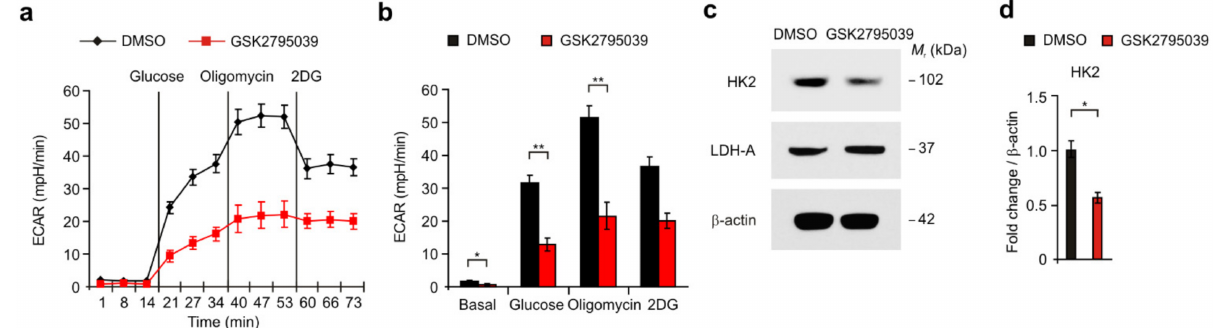
Figure 3. Inhibition of NOX2 suppresses the activation of HK2-dependent glycolysis in human glioma cells. ( a ) The levels of extracellular acidification rate (ECAR) for glycolysis of glucose and ( b ) quantifi- cation of ECAR levels in human glioma cells treated with GSK2795039 or DMSO. ( c ) Representative immunoblot images and ( d ) quantification of NOX2, HK2, and LDH-A protein levels in human glioma cells treated with GSK2795039 or DMSO. β -actin was used as a loading control. The results are representative of three independent experiments and are shown as the mean ± SEM. ** p < 0.01, * p < 0.05; ANOVA or Student’s two-tailed t